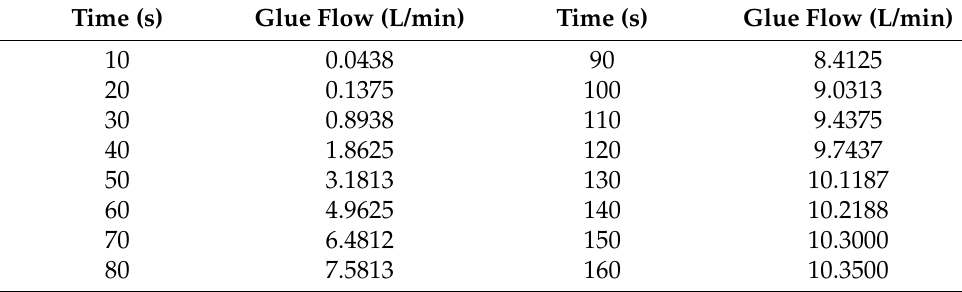
Table 1. Collected data of the glue flow in the dosing system.